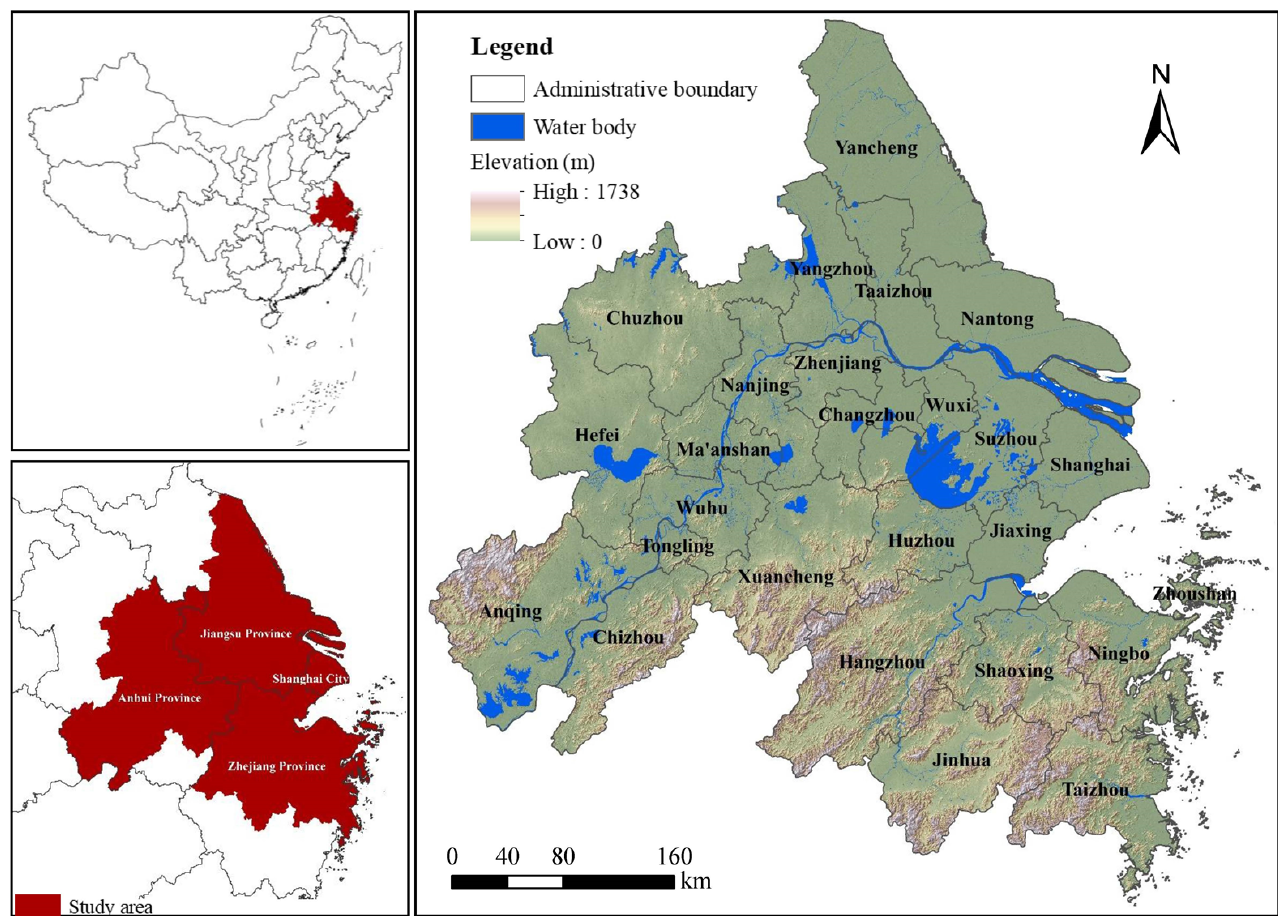
Figure 1. The YRD.